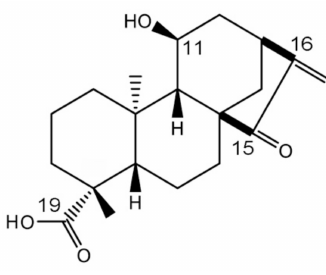
Figure 1. The structure of ent- 11 α -hydroxy-15-oxo-kaur-16-en-19-oic acid (11 α